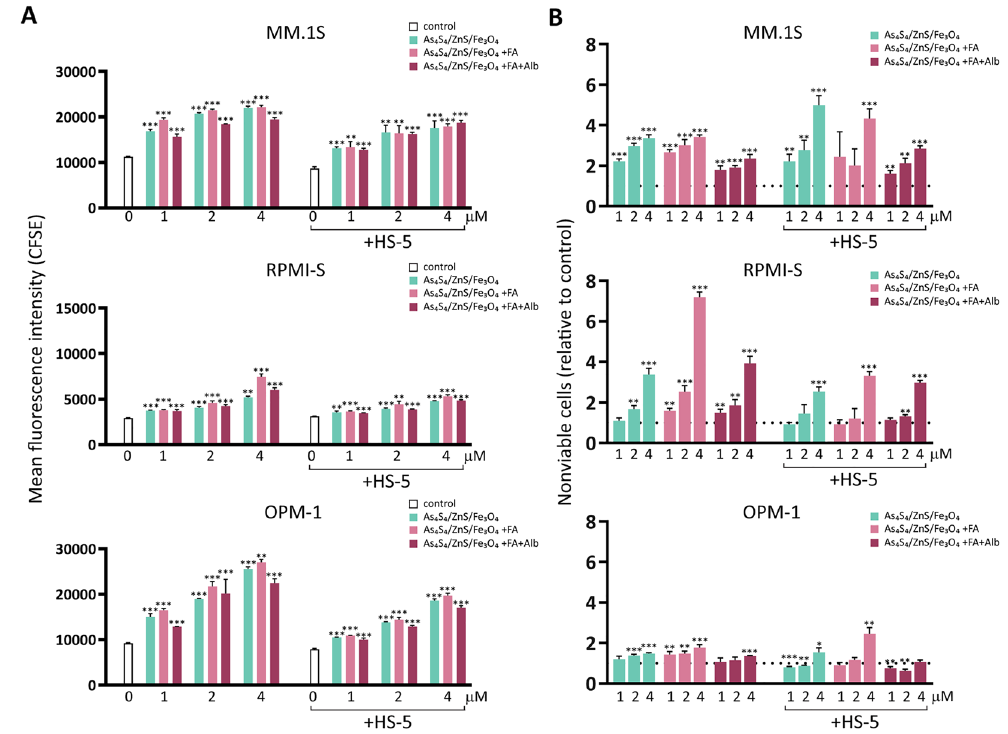
Figure 5. As 4 S 4 /ZnS/Fe 3 O 4 (1:4:1), As 4 S 4 /ZnS/Fe 3 O 4 (1:4:1) with FA, and As 4 S 4 /ZnS/Fe 3 O 4 (1:4:1) with FA and Alb inhibit proliferation of MM cells alone and in co-culture with bone marrow stromal cells (BMSC). Carboxyfluorescein diacetate succinimidyl ester (CFSE)-stained MM.1S, RPMI-S and OPM-1 cells, alone or in co-culture with BMSC HS-5 cells, were treated with all 3NPs at 1, 2, and 4 µM for 48 h. Non-viable MM (CFSE +/PI +) cells were determined by PI staining and analyzed by a FACS Canto II flow cytometer. ( A ) Fluorescence intensity of gated CFSE + PI − -stained MM cells is shown as a function of all 3NPs concentration (1, 2, and 4 µM). ( B ) The ratio of fraction affected (non-viable cells) MM cells triggered by 3NPs relative to untreated controls is shown as a function of all 3NPs concentration (1, 2, and 4 µM). Each treatment with a specific concentration of NPs was done in triplicate. Data are from two independent experiments and are presented as mean ± standard deviation. Significant differences between treatments and control were identified by t-test with * p < 0.05, ** p < 0.01, and *** p <